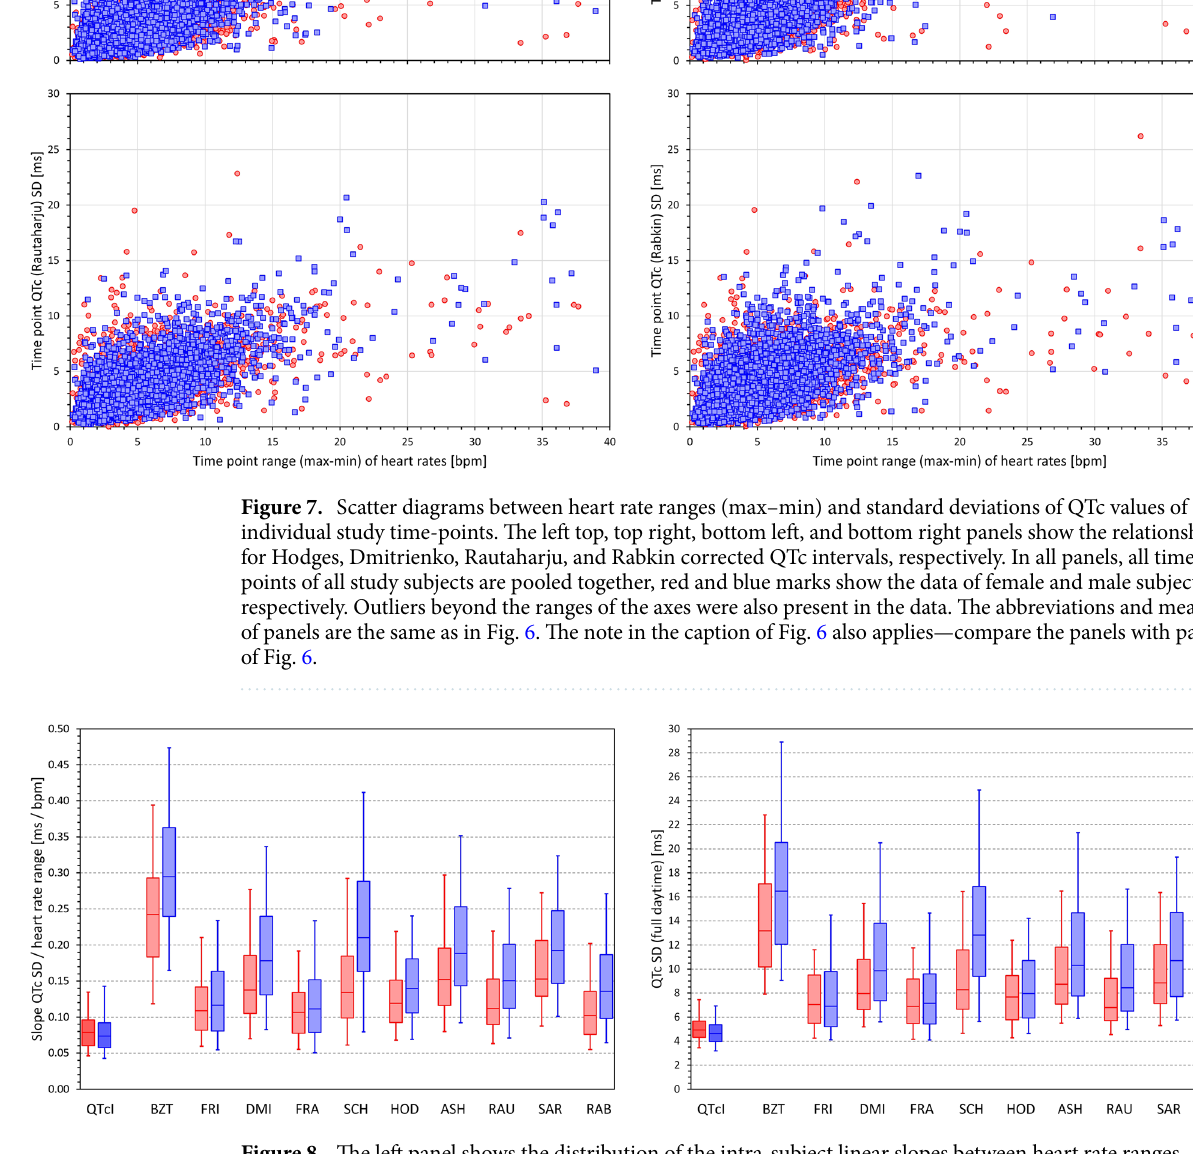
Figure 8. The left panel shows the distribution of the intra-subject linear slopes between heart rate ranges (max–min) and standard deviations of QTc intervals calculated over the different study time-points. The right panel shows the distribution of the intra-subject standard deviations of the QTc intervals calculated over all the ECG readings within the drug-free baseline day. For each correction formula (see the abbreviations at the horizontal axes) red and blue box and whisker entries are shown corresponding to the distribution of the data in female and male subjects, respectively. Each of the box and whisker entries shows the population median (horizontal line within the box), inter-quartile range (the top and bottom of the box) and the range between the 5th and 95th percentile (the bottom and top whiskers). bmp beats per minute, ms milliseconds, SD standard